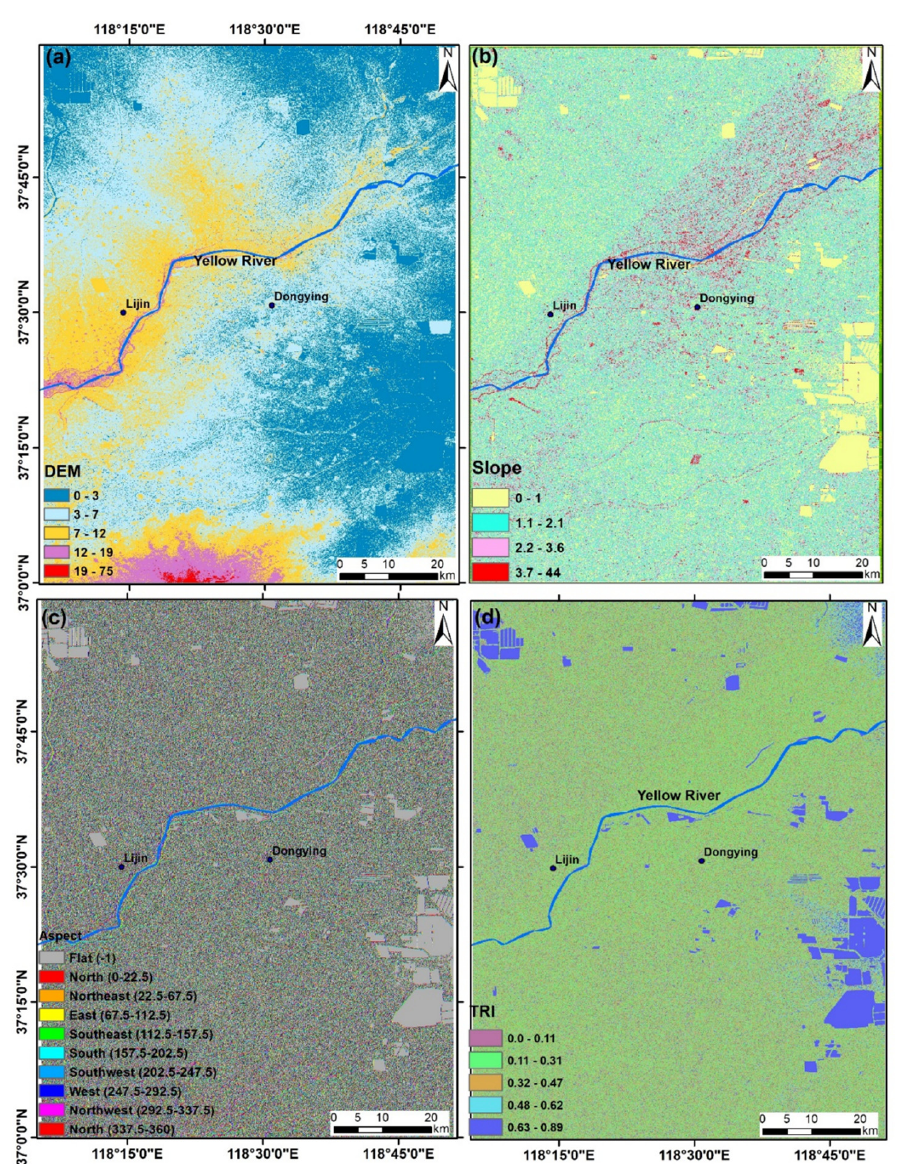
Figure 3. ( a ) Elevation; ( b ) slope; ( c ) slope aspects; ( d ) TRI.